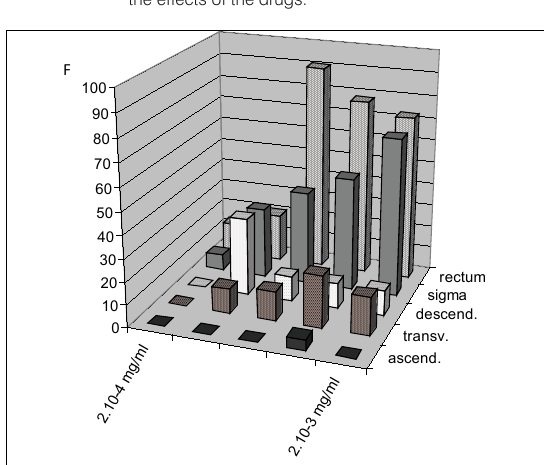
Figure 3. Comparison of the strength of the isometric registered inhibitory effects of drotaverine against hyoscine for tonus of SM colon samples. Every bar shows the degree of dominance of the drotaverine induced effects against hyoscine induced effects. The absence of bars shows drug concentrations where there is no difference between the effects of the drugs.